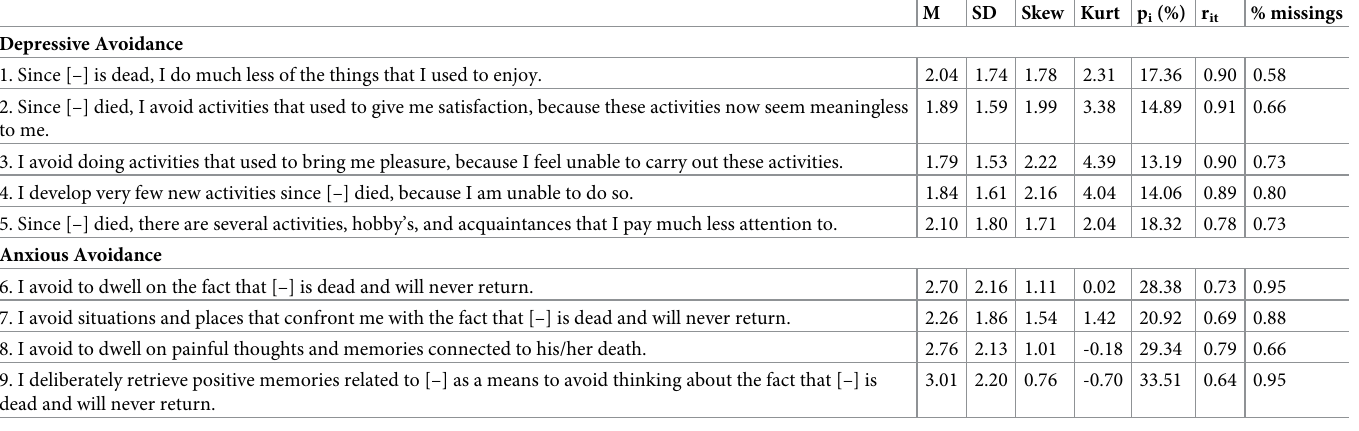
Table 3. Psychometric properties of the DAAPGQ